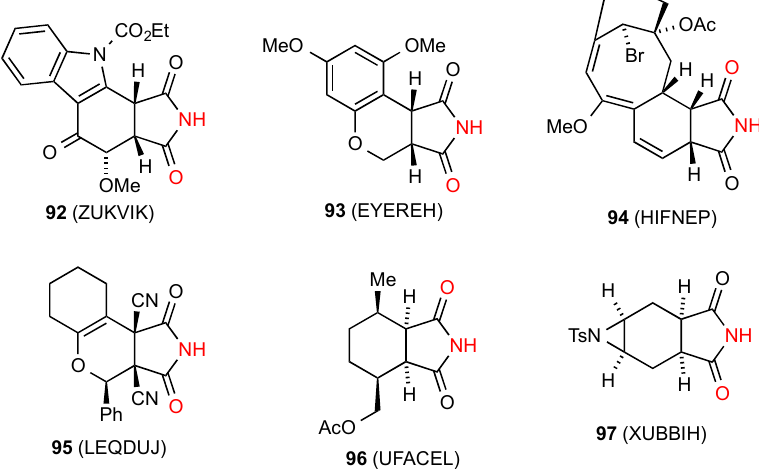
Figure 34. Six-membered ring-fused succinimides showing pattern A dimers.